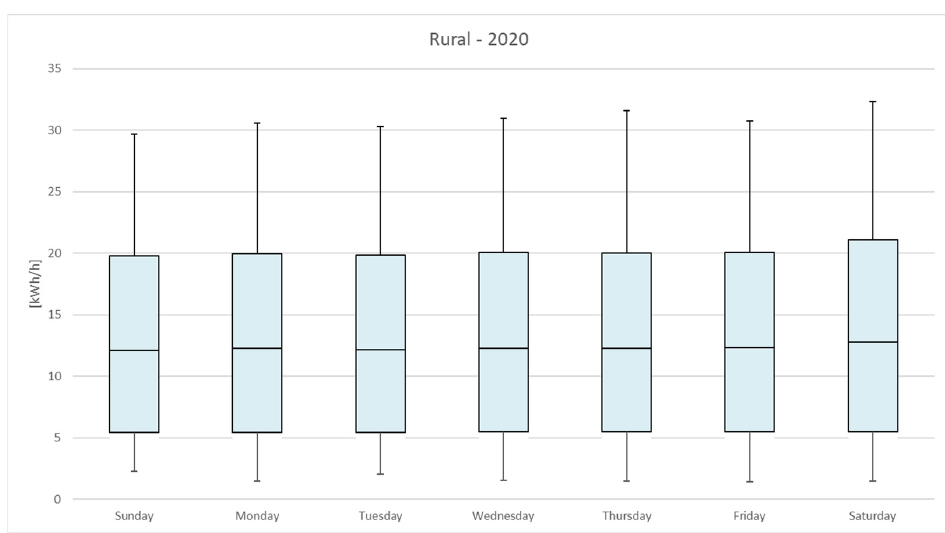
Figure 6. Box and whiskers plots for days of the week in 2020 (rural).